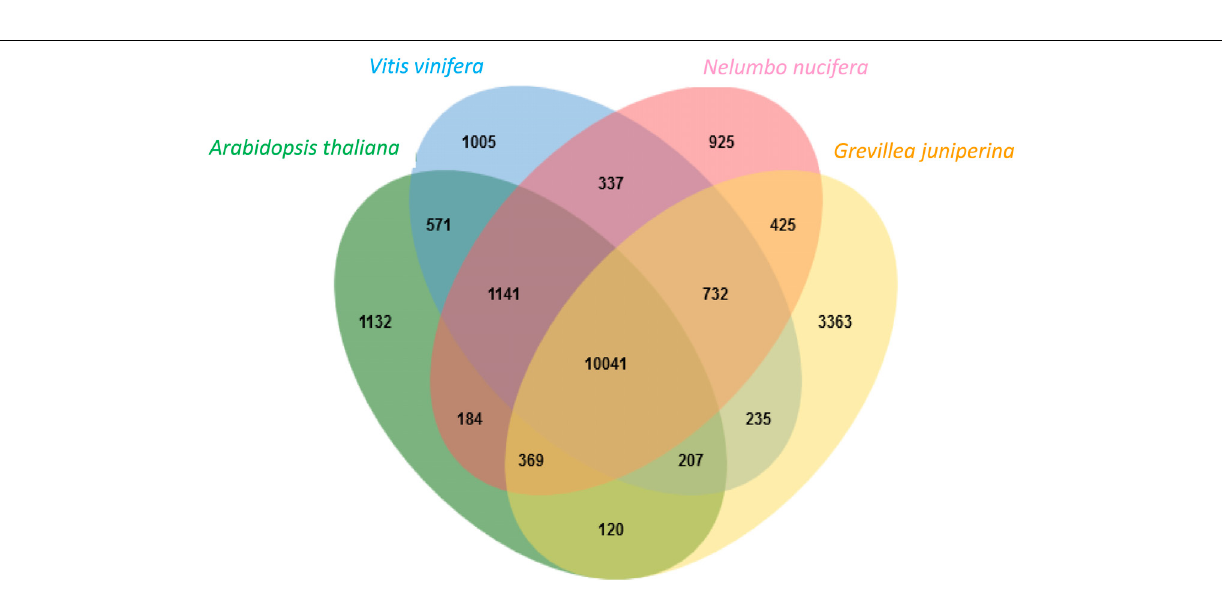
Frontiers in Plant Science |